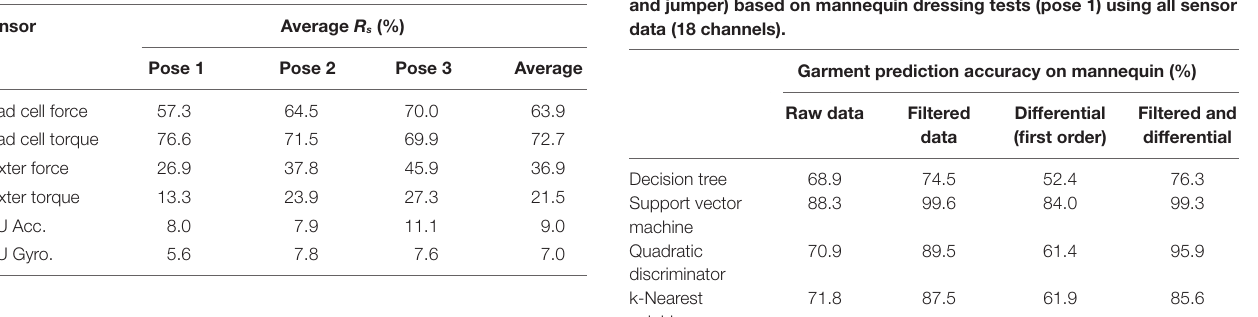
TaBle 1 | sensitivity analysis table.